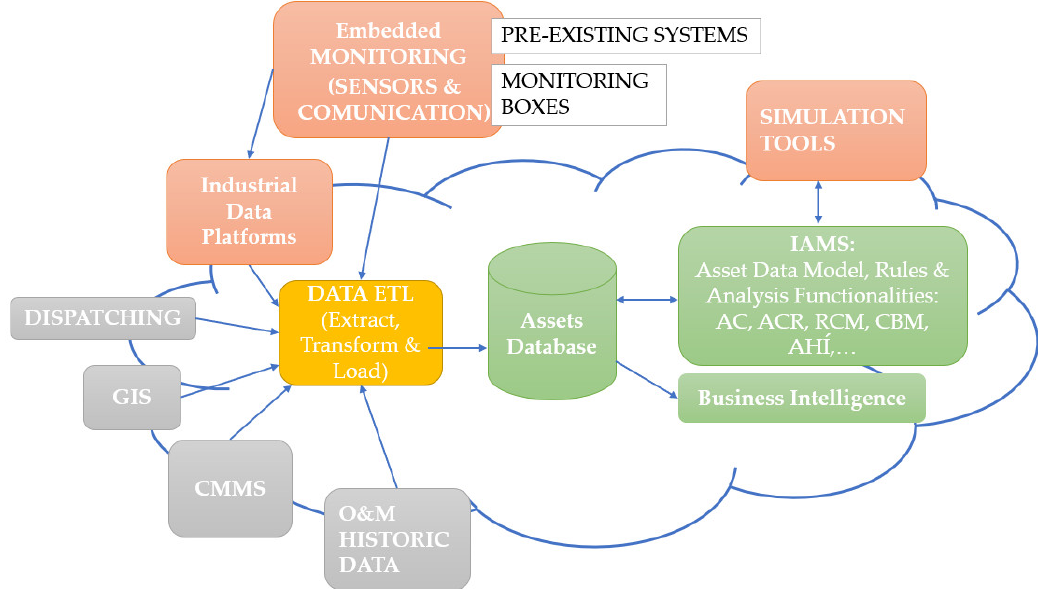
Figure 3. A generic vision of the basic IAMP functional elements.